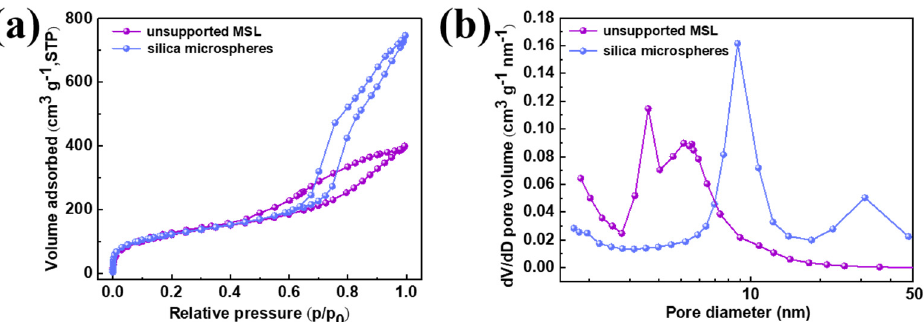
Figure 3. N 2 adsorption-desorption isotherms ( a ) and pore size distribution ( b ) of the silica micro- spheres and unsupported MSL. Table 1. Pore structure parameter of silica microspheres and unsupported MSL. Samples